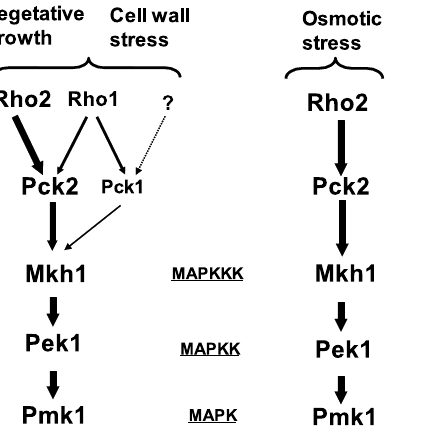
Figure 5. In fission yeast, Rho1 GTPase and PKC ortholog Pck1 are upstream activators of the cell integrity MAPK pathway in addition to Rho2 and Pck2 under specific situations. Sizes of protein names and line arrows intend to show the relative significance of each component of the cascade during signaling to the MAPK module in unstressed growing cells and in cell wall and osmotic stressed cells (please see text for details).